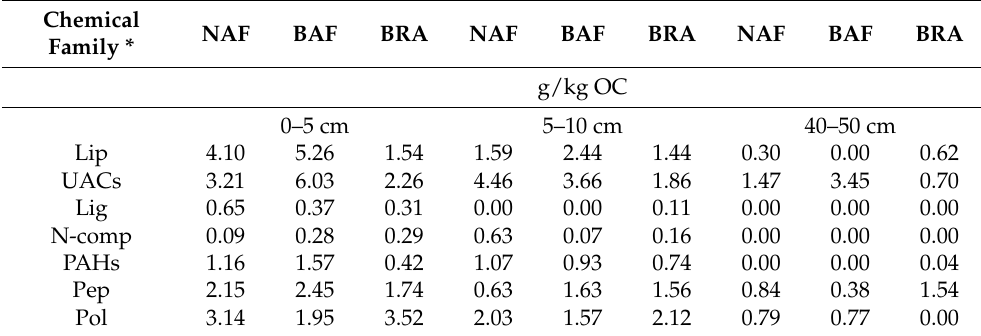
Table 2. Abundance of chemical families released by Py-GC/MS of soil samples collected at 0–5, 5–10 and 40–50 cm depth at the native Amazon Forest (NAF), burned Amazon Forest (BAF) and Brachiaria pasture (BRA) site. Values are relativized to the organic carbon content of the sample (g/kg OC).